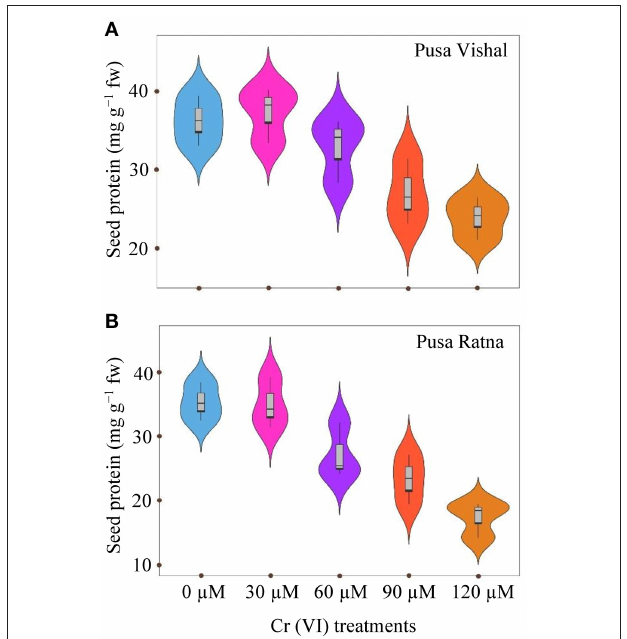
FIGURE 11 | Violin plots screening distribution of values for seed protein content of two mungbean cultivars, (A) Pusa Vishal (PV) and (B) Pusa Ratna (PR), at 63 days after sowing, when grown in pot conditions under chromium (Cr [VI]) stress.